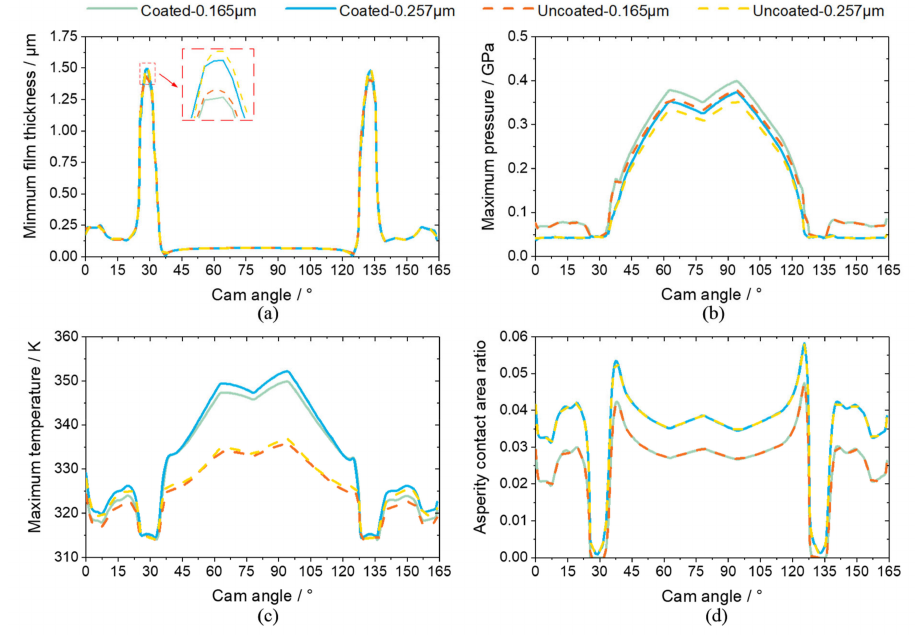
Figure 7. Variations of the lubrication state during a cam cycle under the normal load: ( a ) the minimum film thickness, ( b ) the maximum film pressure, ( c ) the maximum temperature of the lubricant, and ( d ) the asperity contact area ratio.